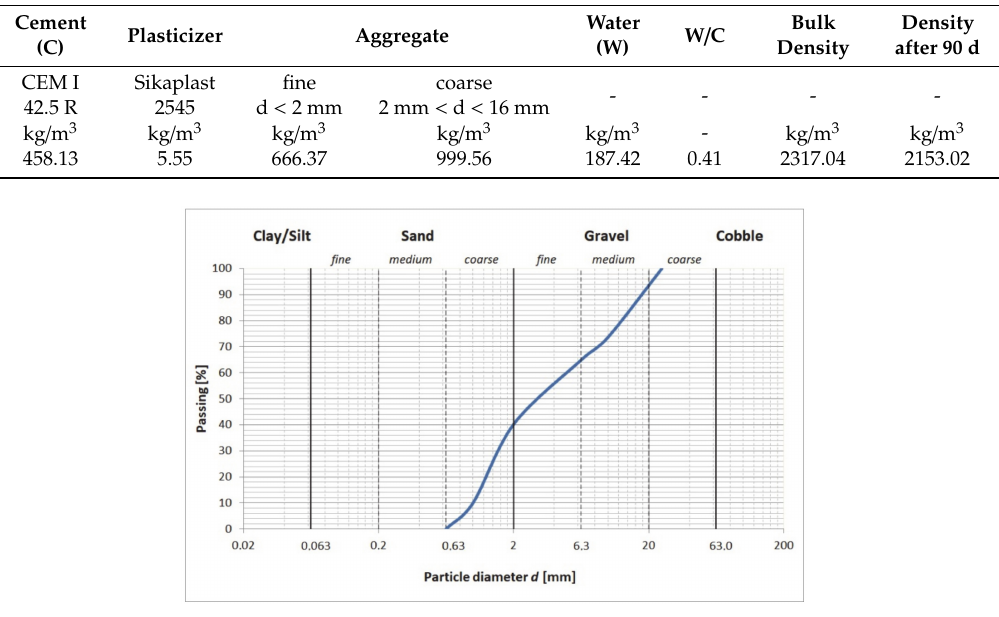
Table 1. Concrete mix composition.